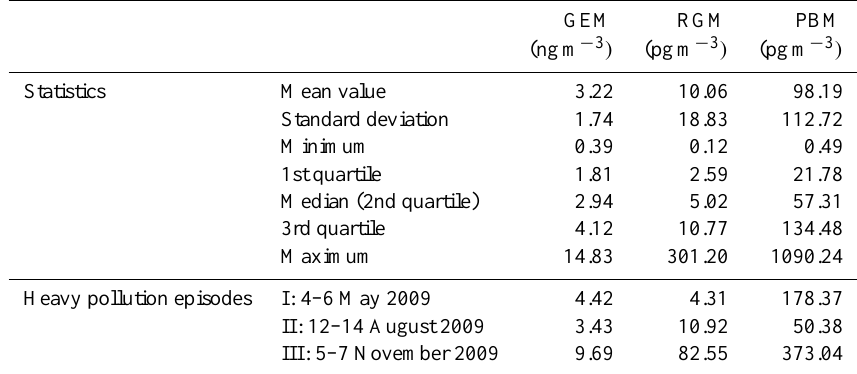
Table 1. Statistics of the overall monitoring data and averages during heavy pollution periods for the GEM, RGM and PBM at Miyun, Beijing.